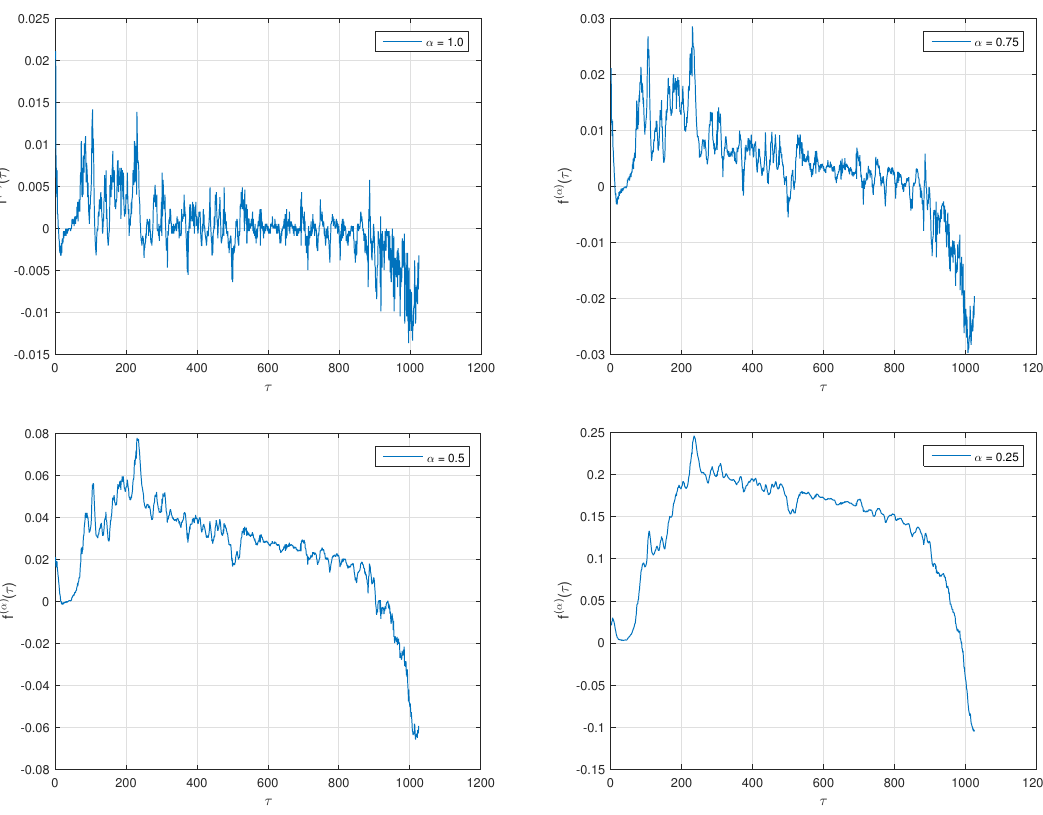
Figure 4. The change of CO and CO 2 concentration for various orders α ∈ ( 0,1 ]